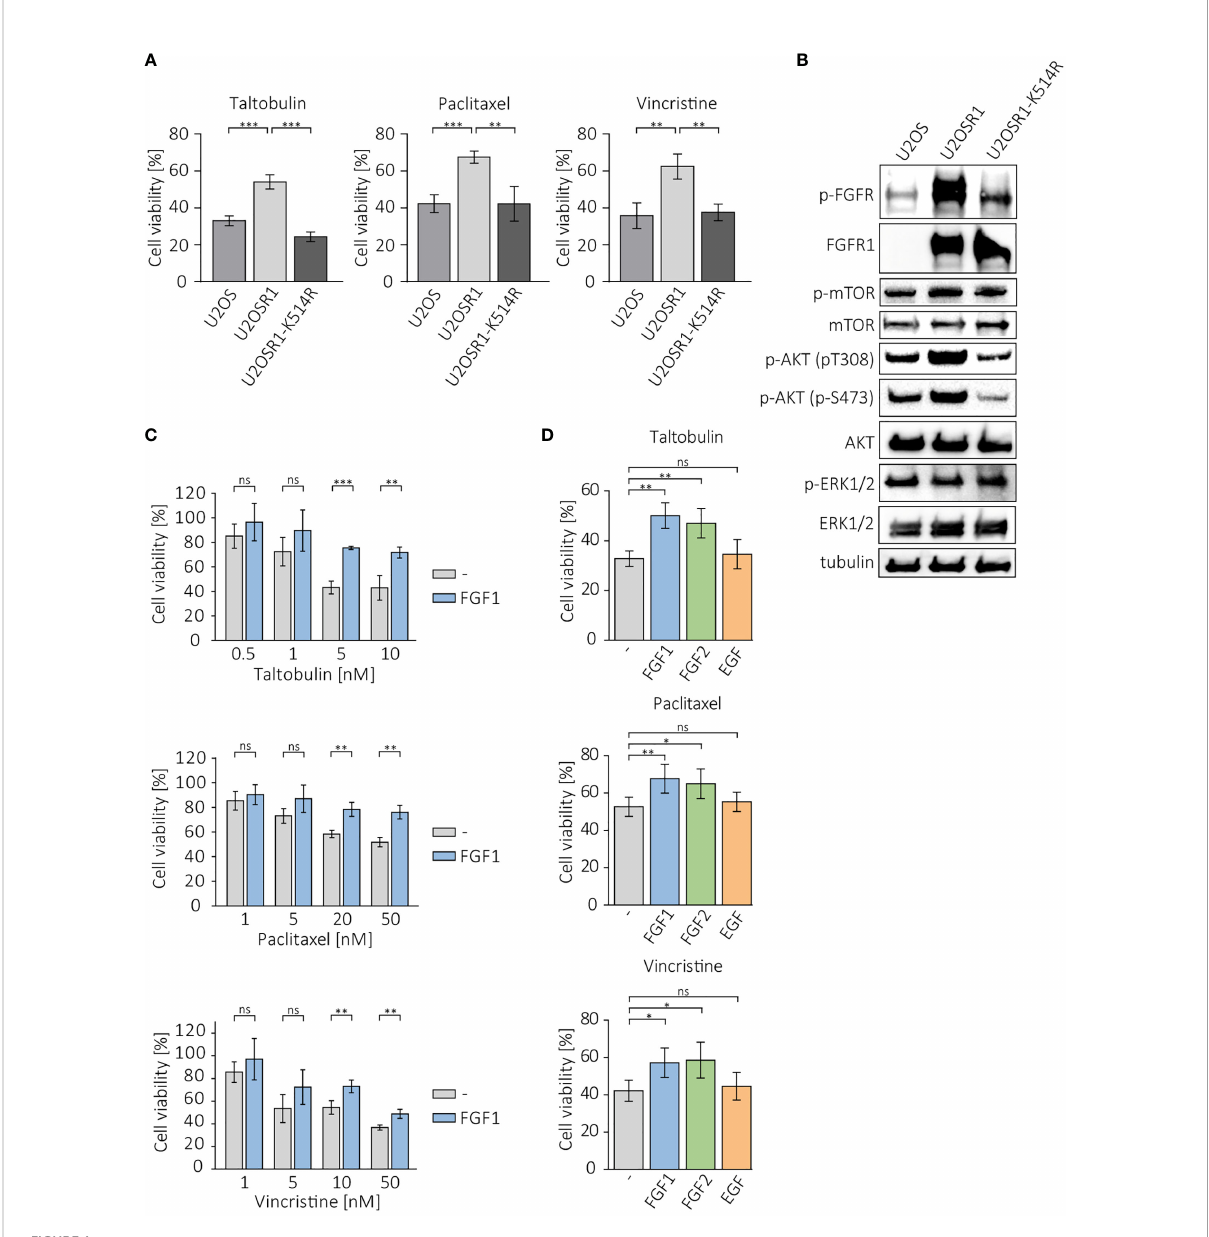
FIGURE 1 Protective effect of FGFR1 activity against cytotoxicity of taltobulin (TLT), paclitaxel (PTX) and vincristine (VCR). (A) Comparison of cytotoxicity of 5 nM TLT, 20 nM PTX, and 10 nM VCR in U2OS sublines. (B) Western blotting analysis of protein level and activation in U2OS sublines performed using the indicated primary antibodies directed to major FGFR-dependent signaling proteins. Anti-tubulin antibody served as an equal loading control. (C) Effect of FGF1 stimulation (10 ng/mL) in U2OSR1 cells treated with different concentration of the indicated drugs. (D) Effect of FGF1, FGF2, and EGF stimulation (10 ng/mL) on drug cytotoxicity in U2OSR1 cells. Cell viability in all experiments was monitored using the alamarBlue assay. Results represent the mean ± SD of at least three independent experiments and are normalized to untreated cells; statistical signi fi cance: *p<0.05, **p<0.01, ***p<0.001, no signi fi cant differences are marked as ‘ ns ’